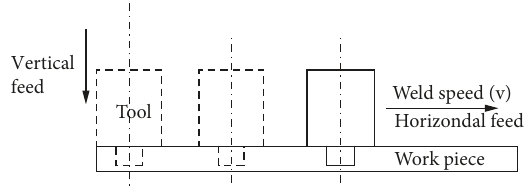
Figure 1: Tool movement at various